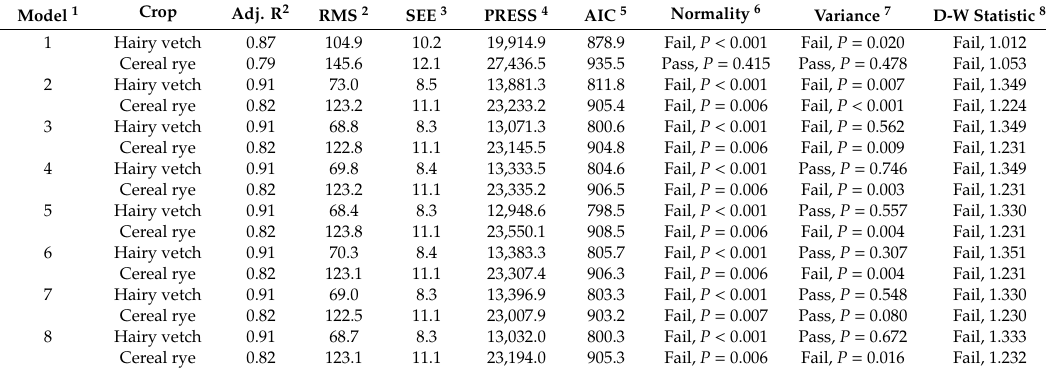
Table 4. Evaluation of models using combined data from Exp. 1 and 2 for percent mass remaining of aboveground hairy vetch and cereal rye cover crops in Carbondale,